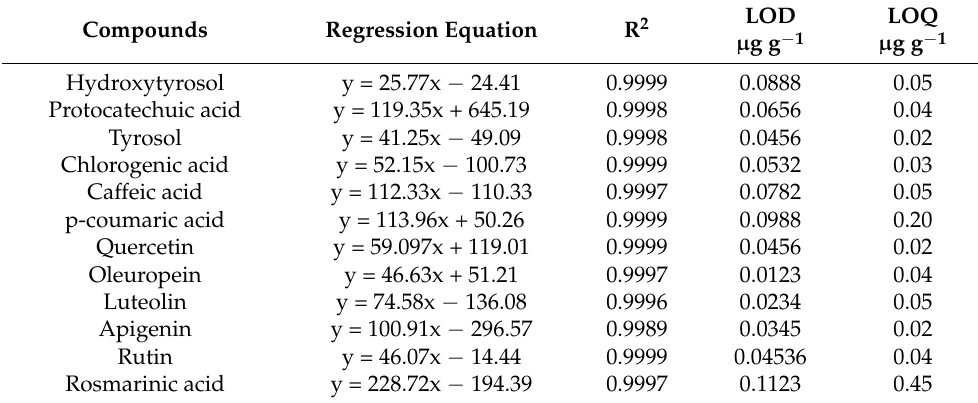
Table 5. Method development through